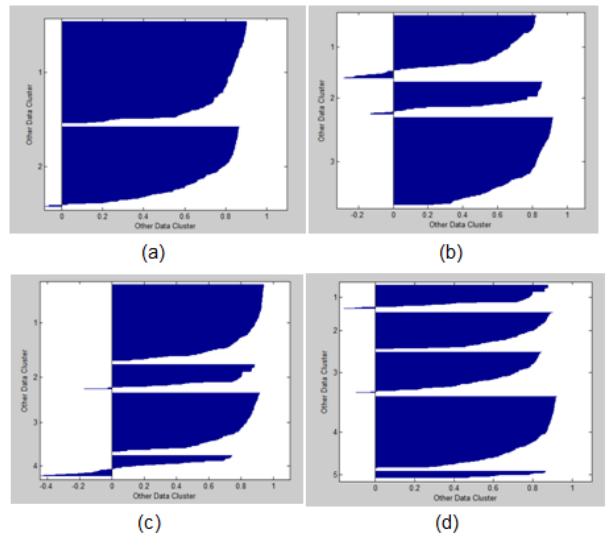
Figure 4. Silhouette plot for Euclidean distance measure: a)K=2 b)K=3 c)K=4